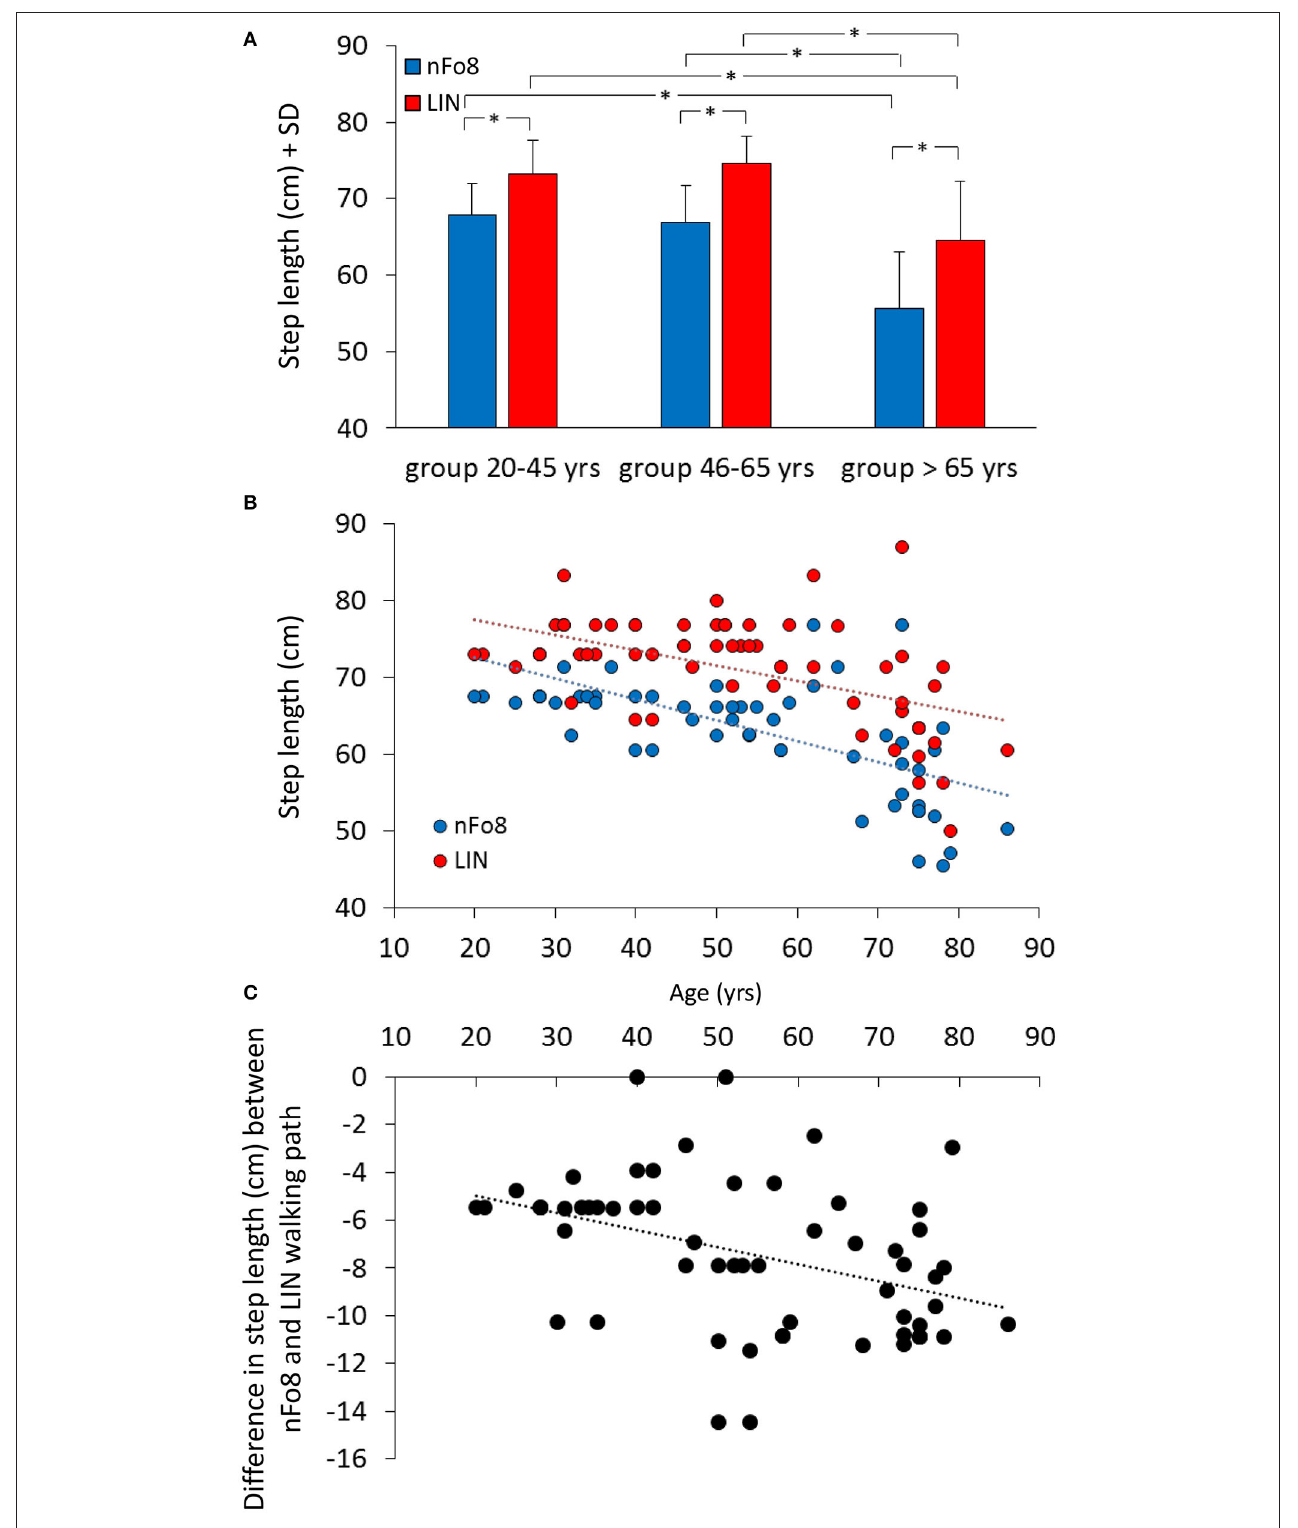
FIGURE 4 | Mean step length (A) and the relationship between step length and age (B,C) . Blue bars and dots refer to the nFo8, red bars and dots refer to LIN. Step length was shorter during nFo8 than during LIN in the three groups of age. Asterisks indicate significant differences. (B) shows the relationship between step length and age: the step length diminished with age for both nFo8 and LIN walking path. (C) shows the relationship with age of the individual differences in step length between the nFo8 and LIN walking paths. The difference (shorter step length with nFo8) increased clearly with age.